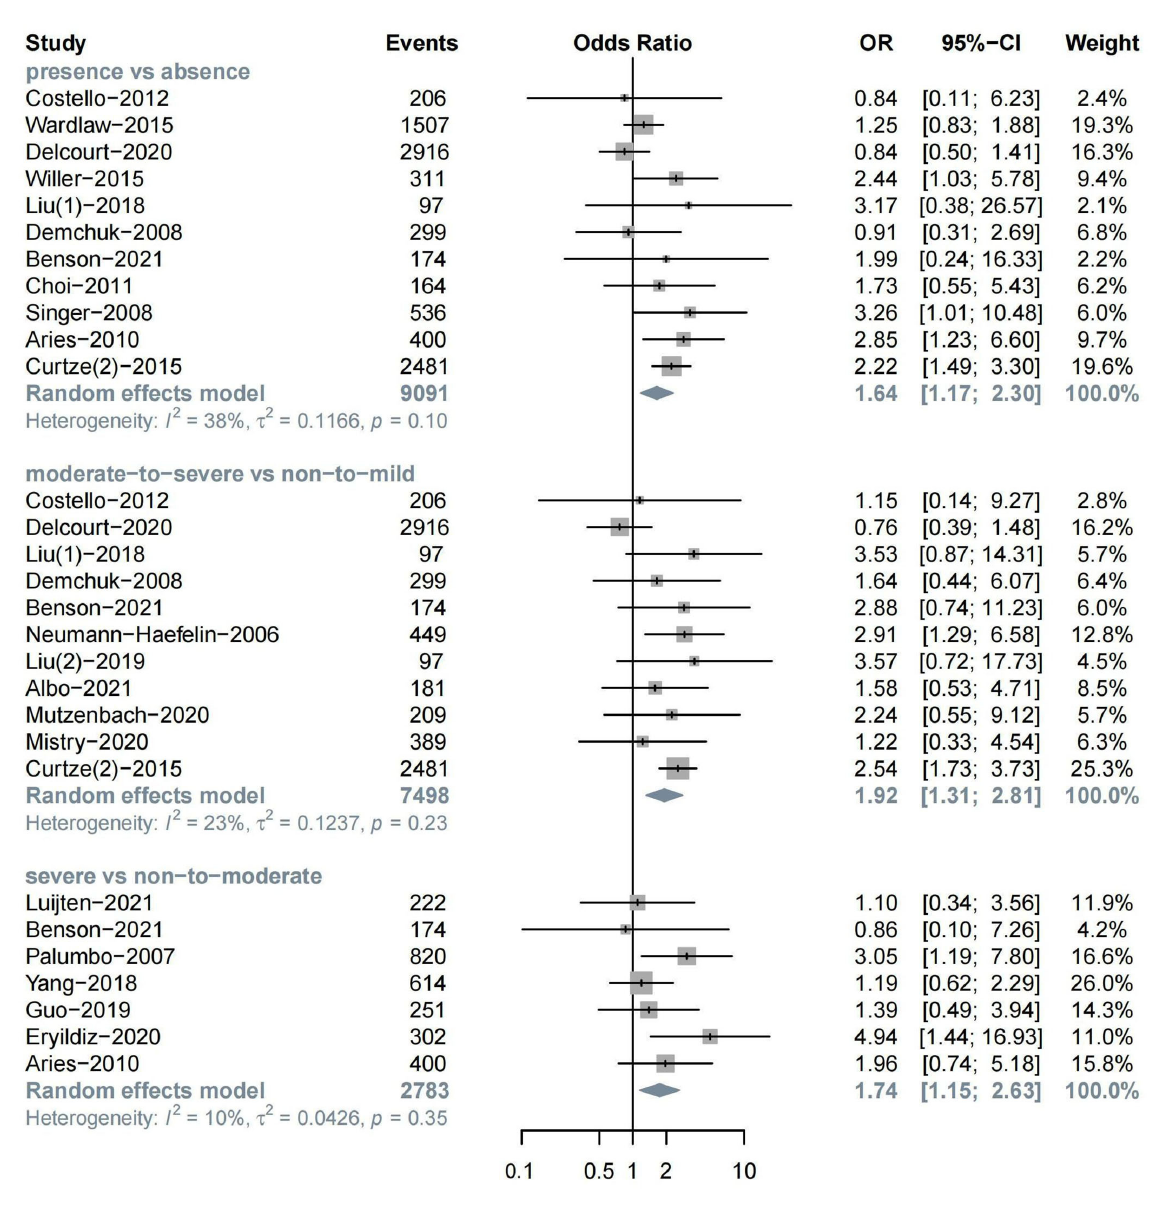
Severity of WML and other subtypes of HT Other subtypes of HT included PH, HI, and rICH. Four